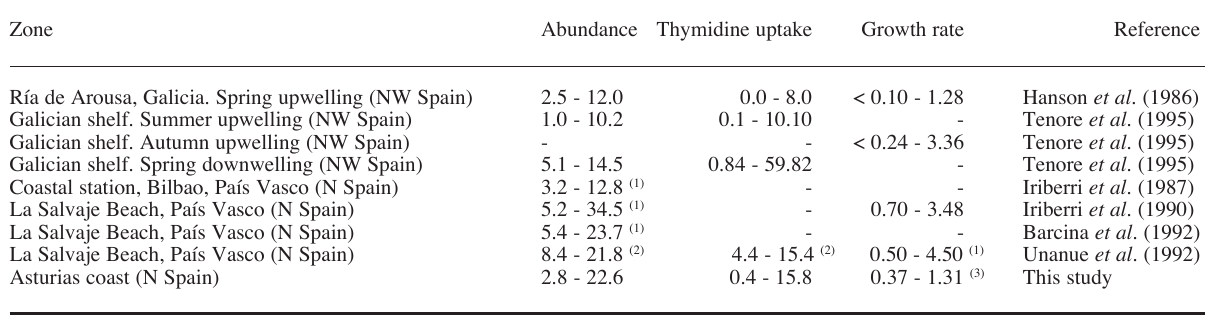
(1) Range of individual values from samples of different seasons. (2) Range of mean values from the cold (winter-spring) and warm (summer- autumn) seasons. (3) Range of mean values from the different shelf